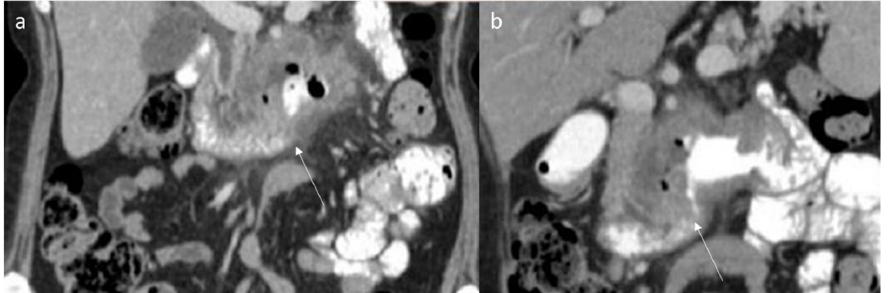
Figure 9. Duodenal carcinoma (arrow) in MPR coronal plane ( a , b ) of CT assessment during portal phase of contrast study. The duodenum has thickened walls with inhomogeneous contrast enhance- ment.